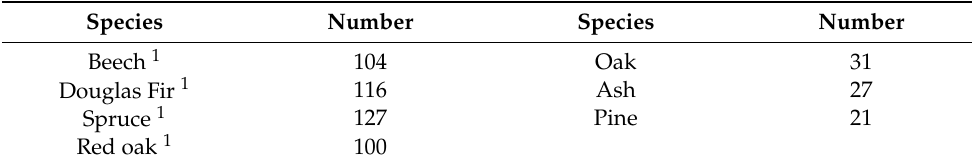
Table 1. Information on tree species and number of